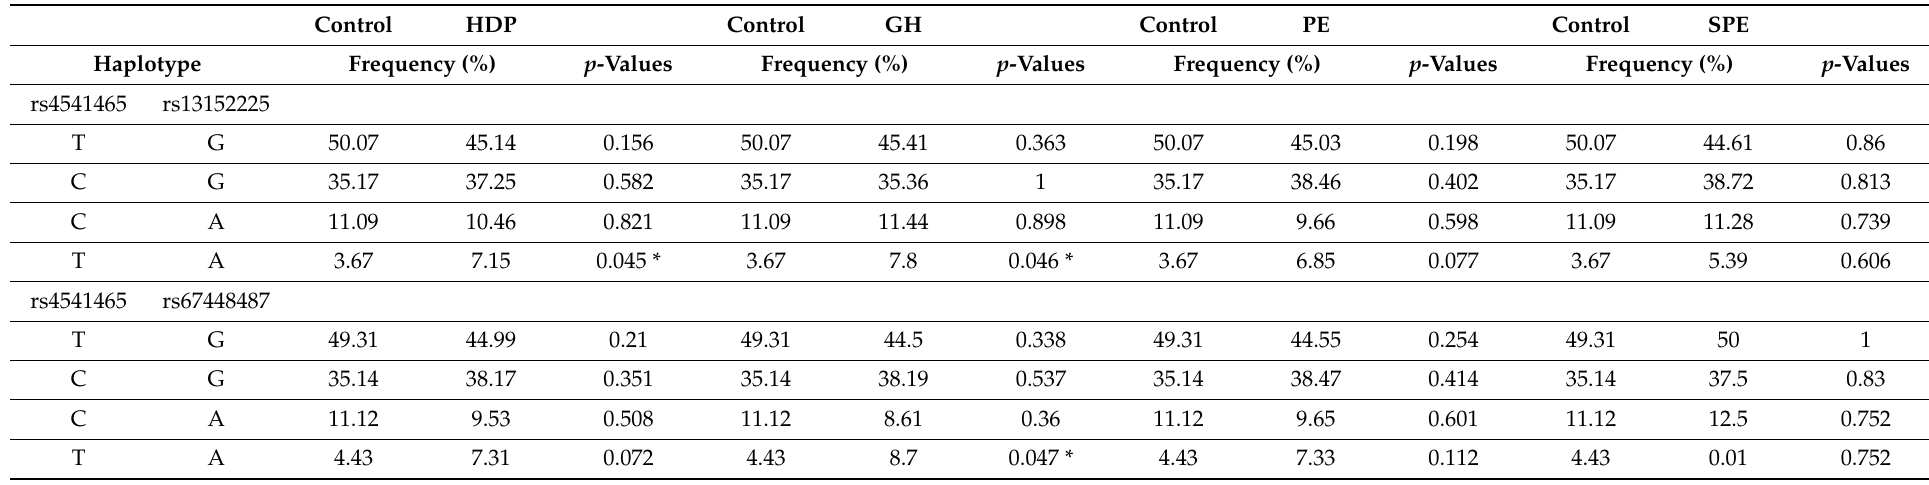
Table 4. Haplotype-based case-control study between the control and HDP groups using single-nucleotide variants.